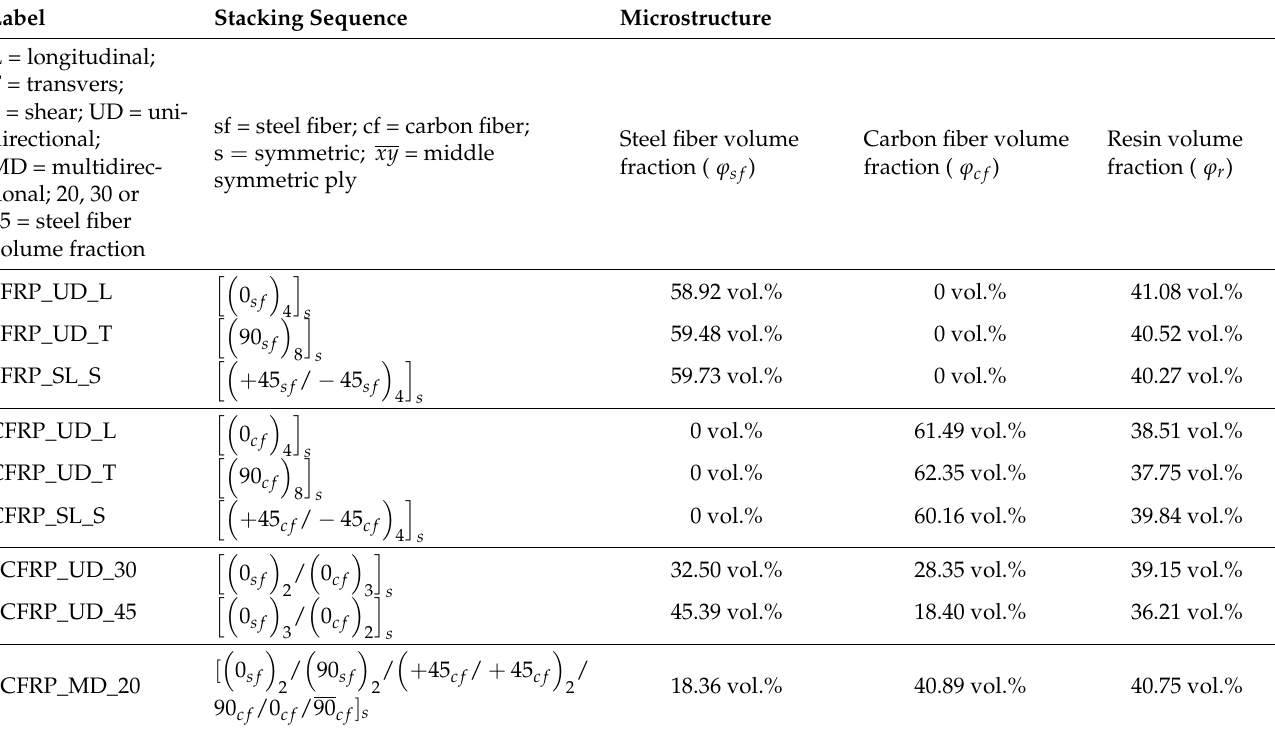
Table 1. Manufactured laminate configurations, including their stacking sequence and volume fractions measured by fiber counting using a Hough transform-based circle